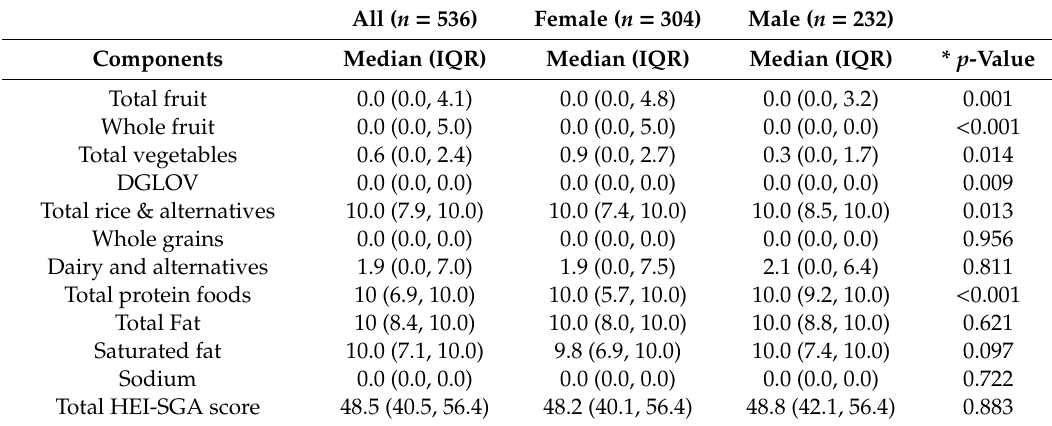
Table 2. Median component and total HEI-SGA values across all participants and by